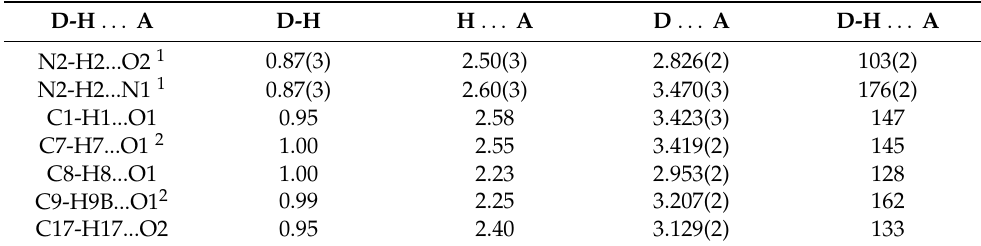
Figure 3. Hydrogen bond contacts in 4 . The molecules of 4 are packed by three hydrogen bonds presented as red-dotted lines in Figure 3. The molecules are packed via strong N2-H2...O2 with donor–acceptor distances of 2.826(2) Å (Table 3). Additionally, the N2-H2...N1, C7-H7...O1 and C9-H9B...O1 have longer interactions distances of 3.470(3), 3.419(2) and 3.207(2) Å, respectively (Figure 3, right part). Table 2. Hydrogen bond parameters (Å and ◦ ) for 4 .